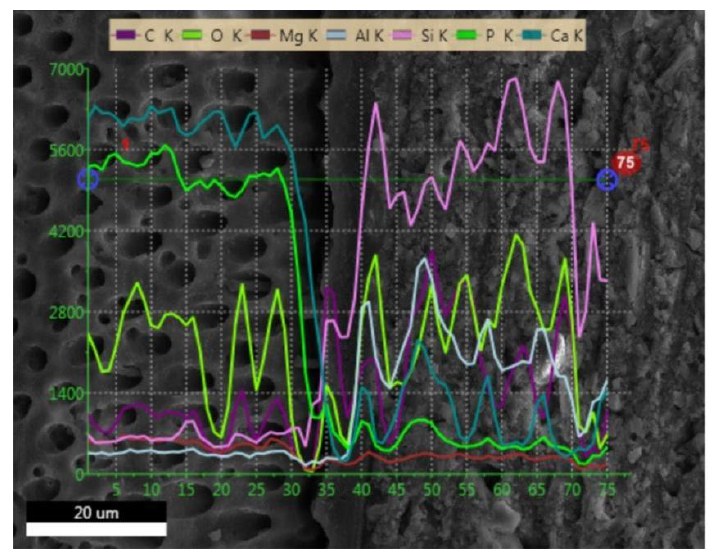
Figure 7. EDS line scan signals of individual elements present at dentin-resin interface obtained for Single Bond Universal applied twice in 40 s (group 2A40).